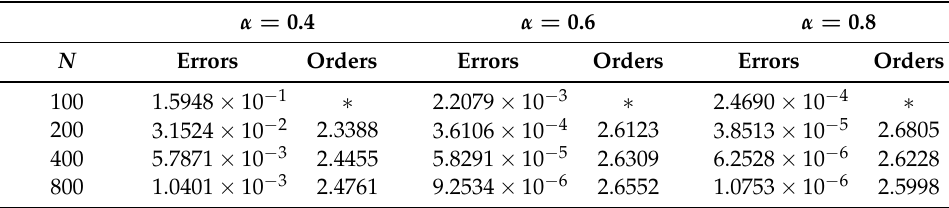
Table 4. Errors and orders in temporal direction for Scheme IV (Example 1).